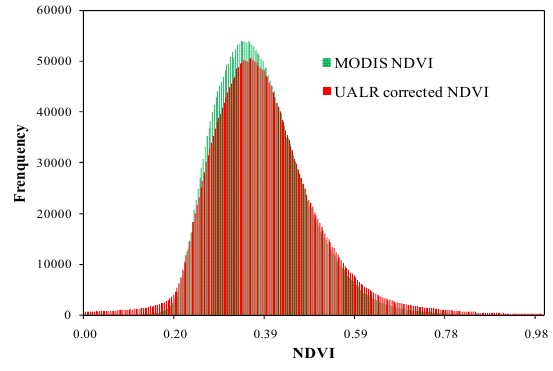
Figure 7. The frequency distribution of MODIS NDVI and UALR-adjusted NDVI for early June